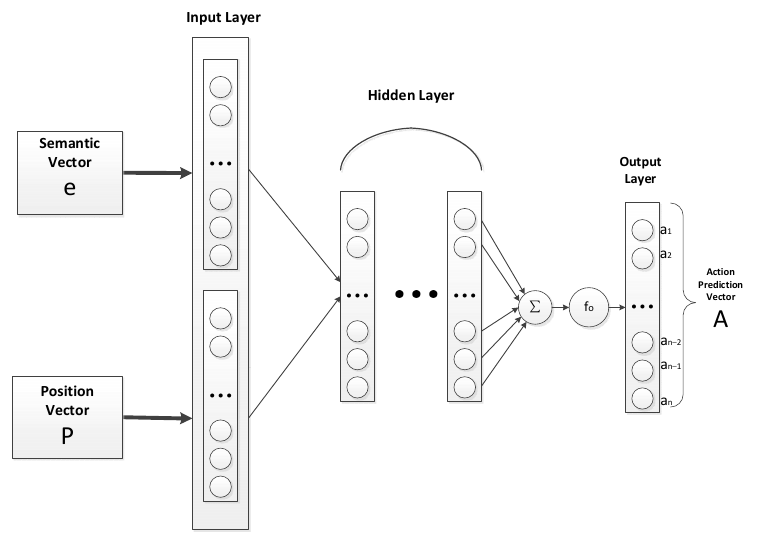
Figure 3. The structure of SPMLP model.